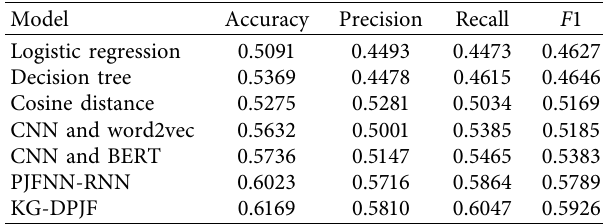
Table 5: The comparative experiment—no structured data.